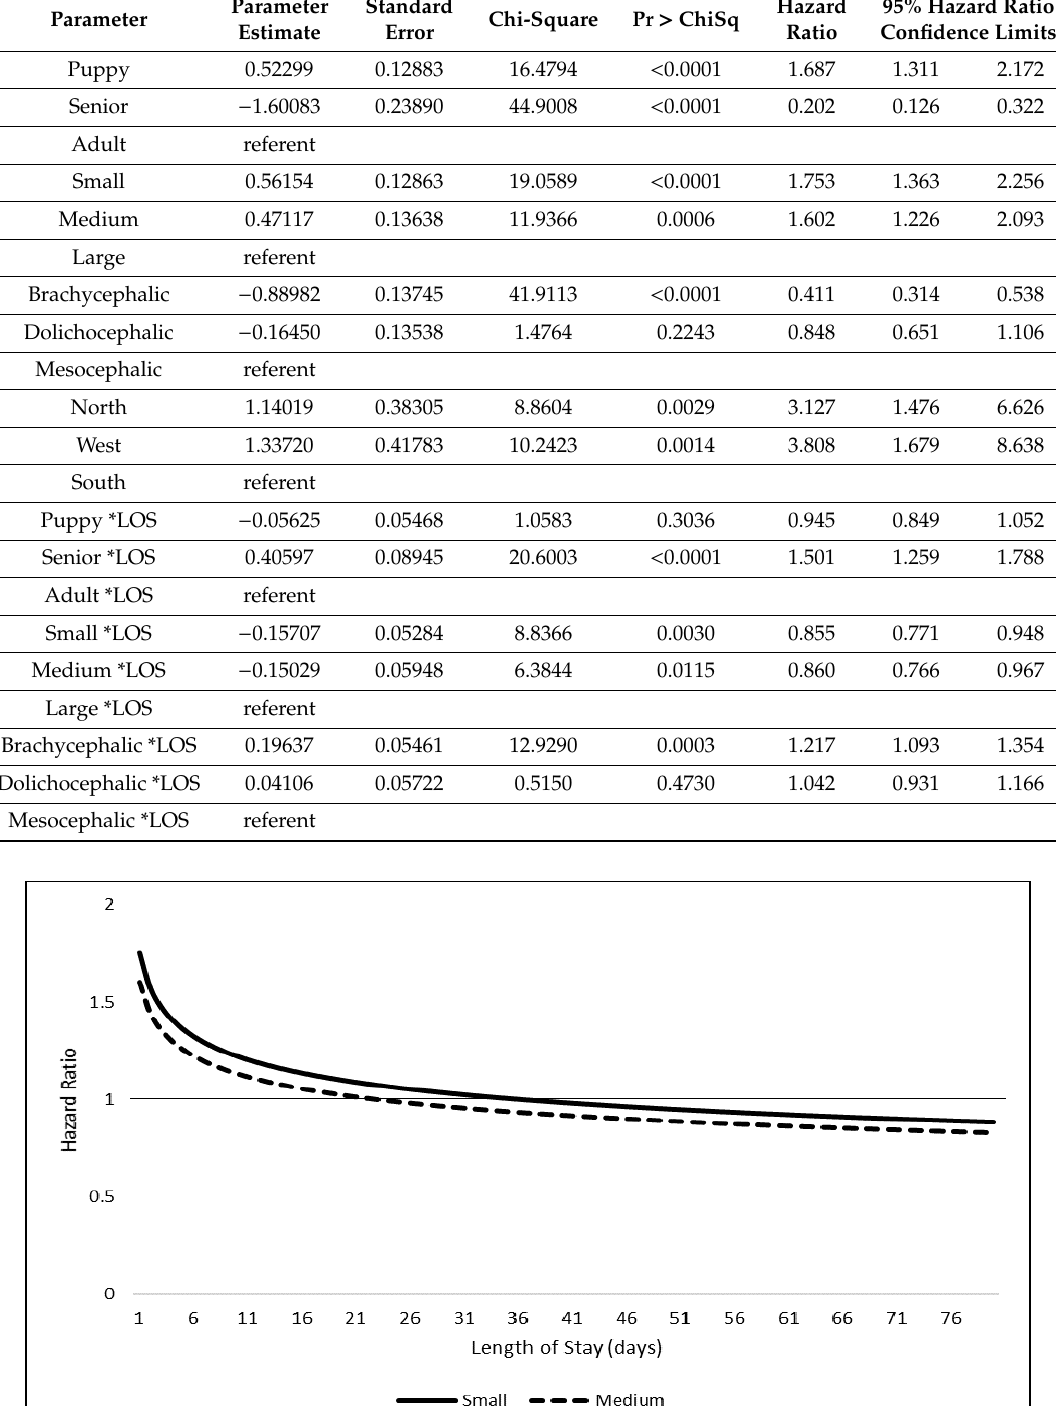
Figure 2. Model adjusted estimated adult size by length of stay interaction displayed as hazard ratios, estimated from the simple random sample of 4500 dogs compared to the referent large group.